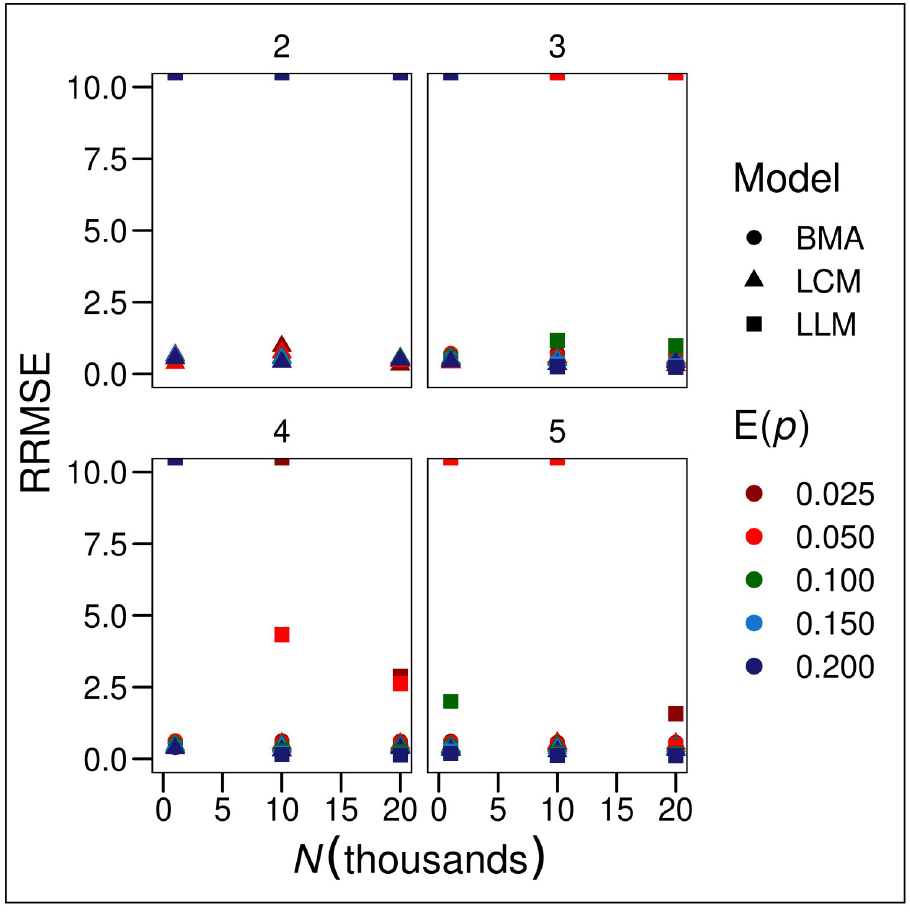
Fig 3. Relative root mean-squared errors (RRMSE = RMSE � N ) of estimators of population size. LLM-AIC denotes loglinear model selection, LLM-BMA denotes Bayesian model-averaging of loglinear models, BLCM denotes nonparametric Bayesian latent-class model estimation and E( p ) denotes expected encounter